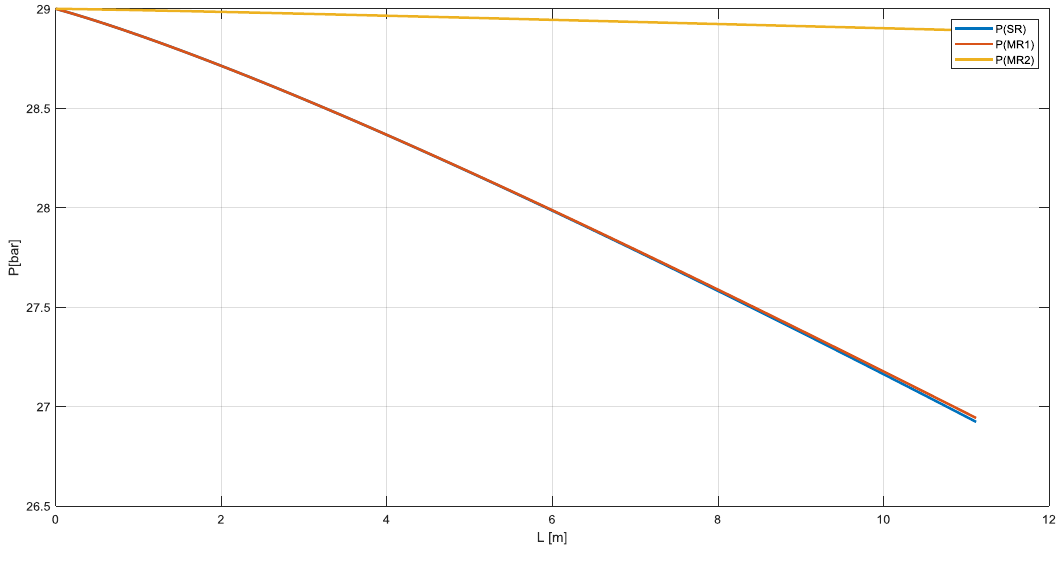
Figure 6. Pressure profile in SR, MR1, and MR2.